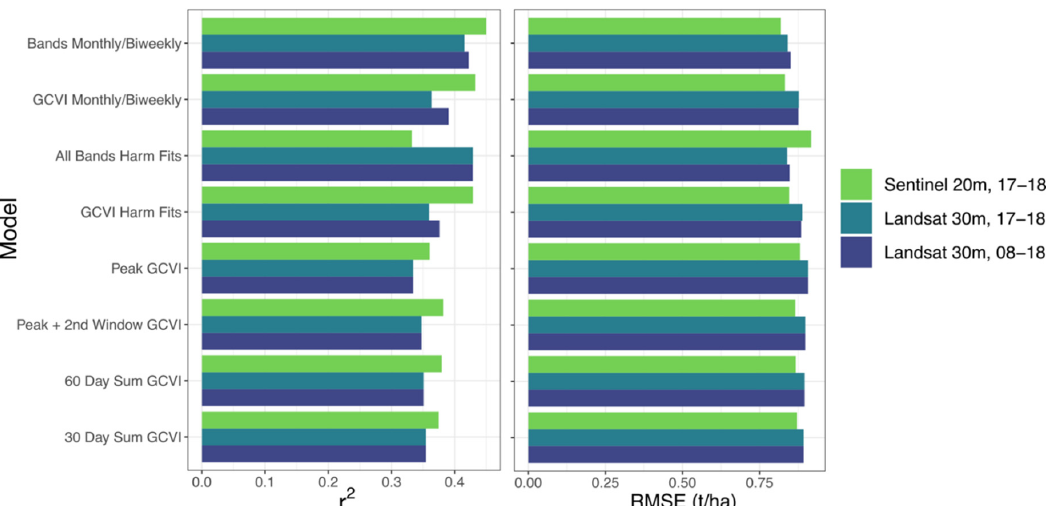
Figure 3. Pixel Scale Random Forests Comparison. Validation statistics for models trained on pixel yield data on held-out pixel-level validation data. Legend refers to the input satellite data, spatial resolution of yield and satellite data, and the temporal extent (Table 1, Section 2.5). The implementations here all employed random forests based on our three main feature engineering approaches: monthly / bi-weekly time series (for Landsat and Sentinel-2, respectively), harmonic fits, and VI-metrics (Section 2.4). For Sentinel, the preferred model is based on biweekly time series of all bands, while for Landsat the harmonic coefficients perform the best.